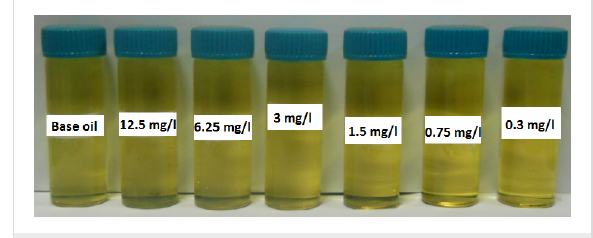
Figure 2: N-rGO dispersion nanolubricant at different concentration.